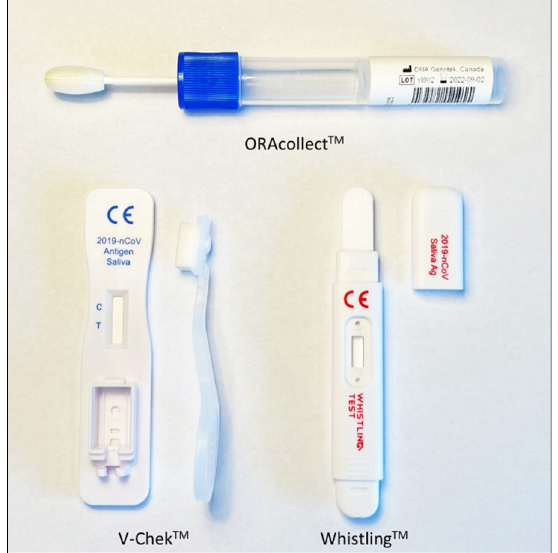
Figure 1. Overview of the three tests: the ORAcollect TM saliva swab as a screw cap on the pre- barcoded tube containing virus inactivating medium ( top ), the V-Chek TM test card and saliva swab ( bottom left ), and the Whistling TM midstream test with absorbent tip for saliva ( bottom right ).